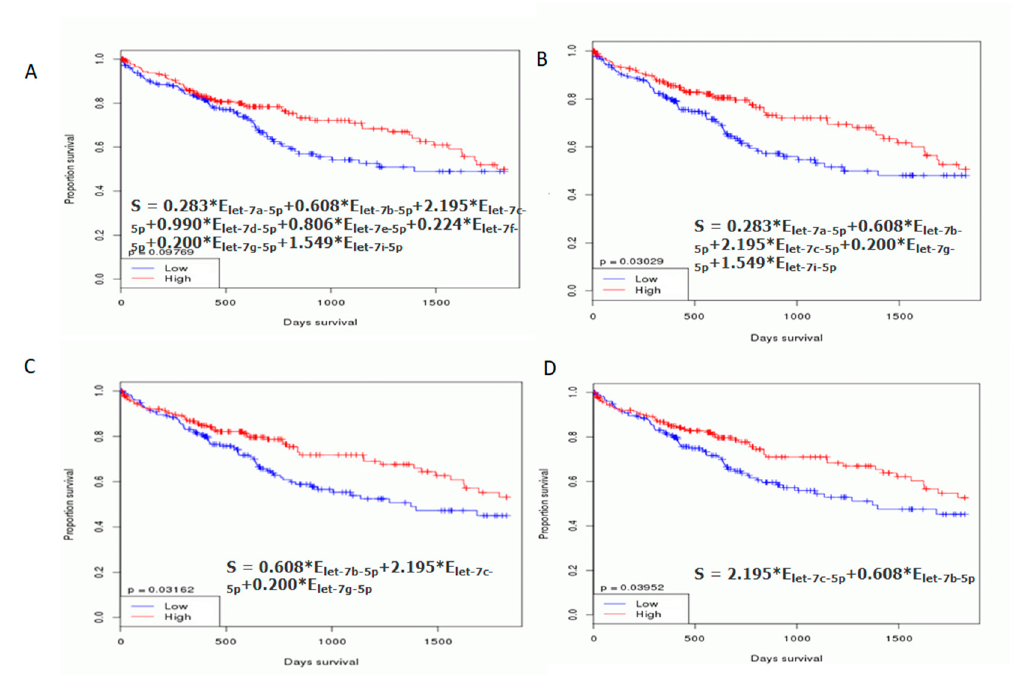
Figure 4. Kaplan–Meier (KM) survival analysis curve for let-7 family expression in TCGA-LIHC patients. The KM survival curves were examined according to ( A ) let-7 a/b/c/d/e/f/g/i expression level and ( B ) let-7 a/b/c/g/i expression levels. No differences in overall survival were observed. ( C ) let-7 b/c/g expression levels and ( D ) let-7 b/c expression levels show clear differences in overall survival. Statistical significance was obtained by log-rank tests, with α = 0.05.